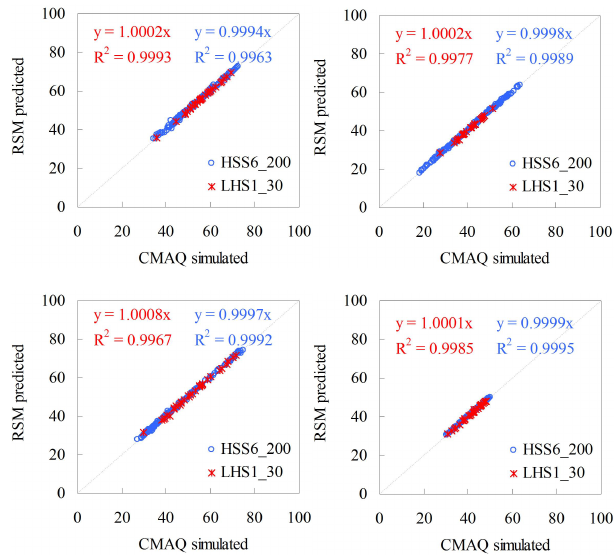
Fig. 4. Leave-one-out cross-validation of two RSM-Ozone cases (monthly mean of daily 1-h maxima Ozone,